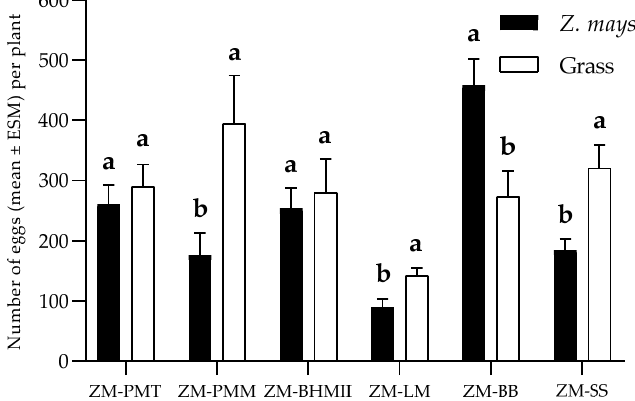
Figure 4. Number of eggs (Mean ± SEM) oviposited per plant by S. frugiperda in two-choice test. Different letters indicate the existence of significant difference in the t-test ( p < 0.05). ZM = Z. mays ; PMT = P. maximum cv. Tanzania; PMM = P. maximum cv. Mombasa; BHMII = B. hybrid cv. Mulato II; LM = L. multiflorum ; BB = B. brizantha and SS = S. sudanense.